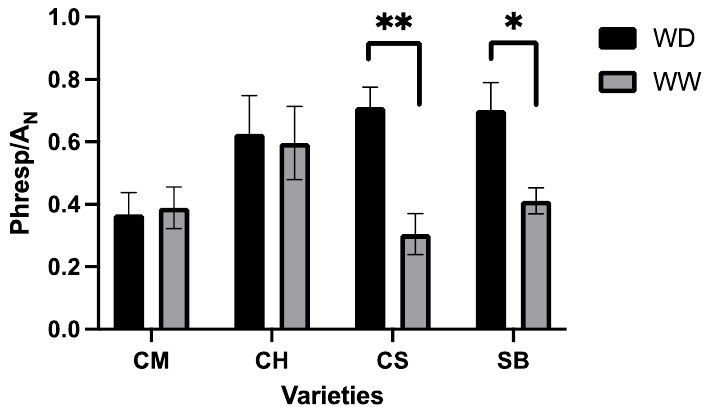
Figure 6. Relationship between photorespiration and net CO 2 assimilation for CM, CH, CS and SB where black is WD and grey is WW. Error bars represent SE. Single asterisk represents significant differences between treatments for each variety p ≤ 0.05. Double asterisk represents significant differences between treatments for each variety p ≤ 0.01.